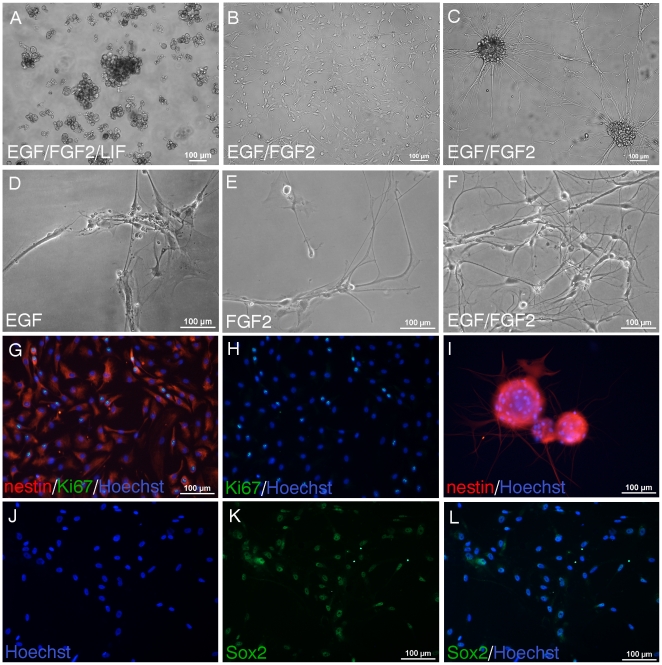
Adult human spinal cord NSPC require an adherent substrate for selection and expansion in EGF/FGF2 culture.A, NSPC were cultured from the time of isolation in uncoated tissue culture flasks. Phase contrast image shows primarily aggregates of debris and some cells at 43div in hypoxic EGF/FGF2 culture containing LIF. B-C, In contrast, in the presence of an adhesive substrate, NSPC are selected in EGF/FGF2 medium and can be expanded continuously. B-C, NSPC cultured and passaged as a monolayer on matrigel for 41div (B) can also form neurospheres in adherent culture (C). D-F, NSPC were cultured for 48div as an adherent monolayer on matrigel. In media containing only EGF (D) or FGF2 (E) fewer cells survived compared to media containing both EGF and FGF2 (F). Both EGF and FGF2 were required for expansion and neurosphere formation. Almost all NSPC expressed nestin (red) (G, 26div). NSPC also expressed Ki67 proliferating nuclear antigen (G, green in overlay; H, green; blue, Hoechst nuclear counterstain). I, Cluster of neurospheres were removed from adherent culture (25div), plated on matrigel coated well in EGF/FGF2 medium, and stained with nestin. Most NSPC expressed Sox2 (66div shown) (K, green; J, corresponding Hoechst staining of nuclei; L, merged).